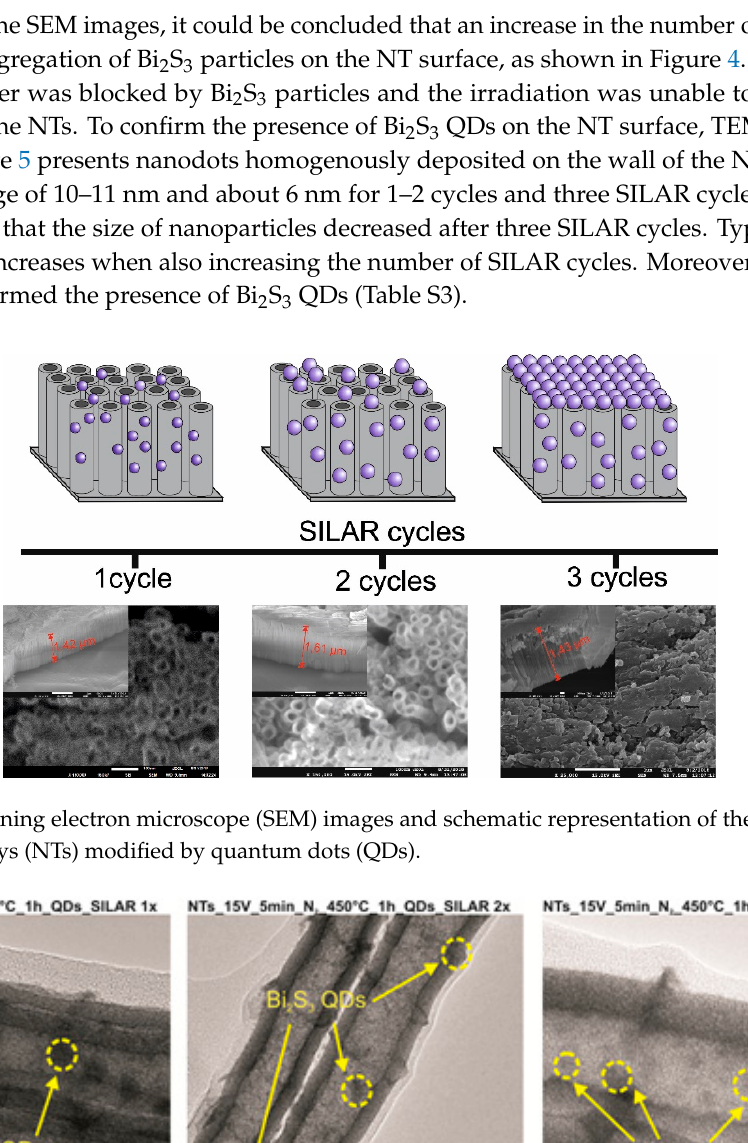
( b ) Figure 6. Photocatalytic activity of selected samples, shown as toluene degradation: ( a ) photocatalyst stability during three irradiation cycles for NTs_15 V_5 min_N 2 _450 °C_1 h and NTs_15 V_5 min_N 2 _450 °C_1 h_QDs_SILAR 1x. ( b ) Efficiency of toluene removal over Ta 2 O 5 nanotube arrays (NTs) and bismuth sulfide (Bi 2 S 3 ) quantum dots (QDs)/Tantalum pentoxide (Ta 2 O 5 ) NTs samples and in the blank tests (toluene photolysis in the absence of a photocatalyst) under monochromatic light— 318 nm and 730 nm . The proposed mechanism of toluene photodegradation over Bi 2 S 3 QDs/Ta 2 O 5 NT composites is presented in Figure 7. Based on the literature [45], it could be concluded that the level of VB and CB of Ta 2 O 5 is − 3.9 and − 7.8 eV in vacuum, respectively. Therefore, electrons of unmodified Ta 2 O 5 NTs during UV-Vis irradiation were excited from the VB to its CB and the reactive pairs of electrons–holes were created. Then, electrons from CB were able to react with oxygen to create superoxide radicals O 2 − , because the potential required to produce O 2 − is − 4.17 eV in vacuum. Additionally, the position